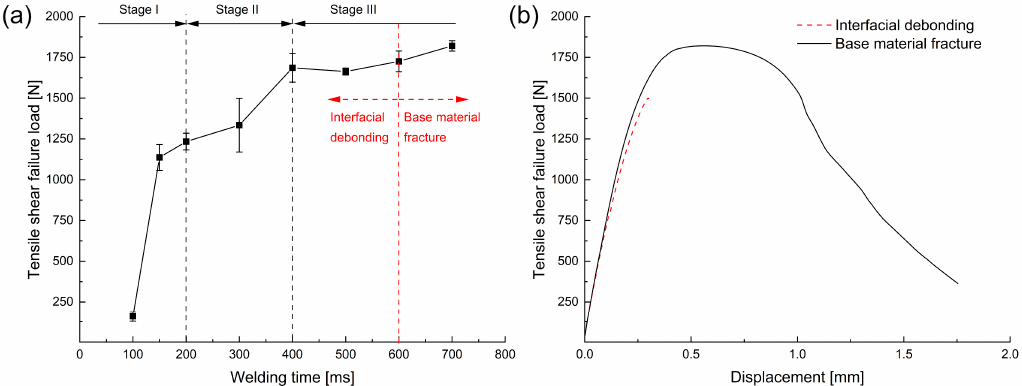
Figure 10. ( a ) Effect of welding time on the tensile shear failure load, and ( b ) load–displacement curves for interfacial debonding and base material fracture modes.